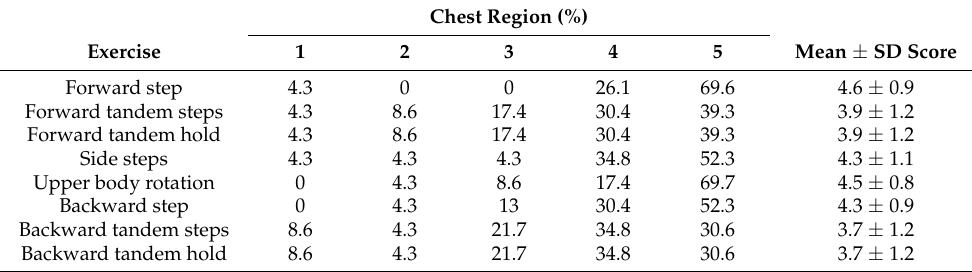
Table 8. Enjoyment scores of the exercises performed at the hip